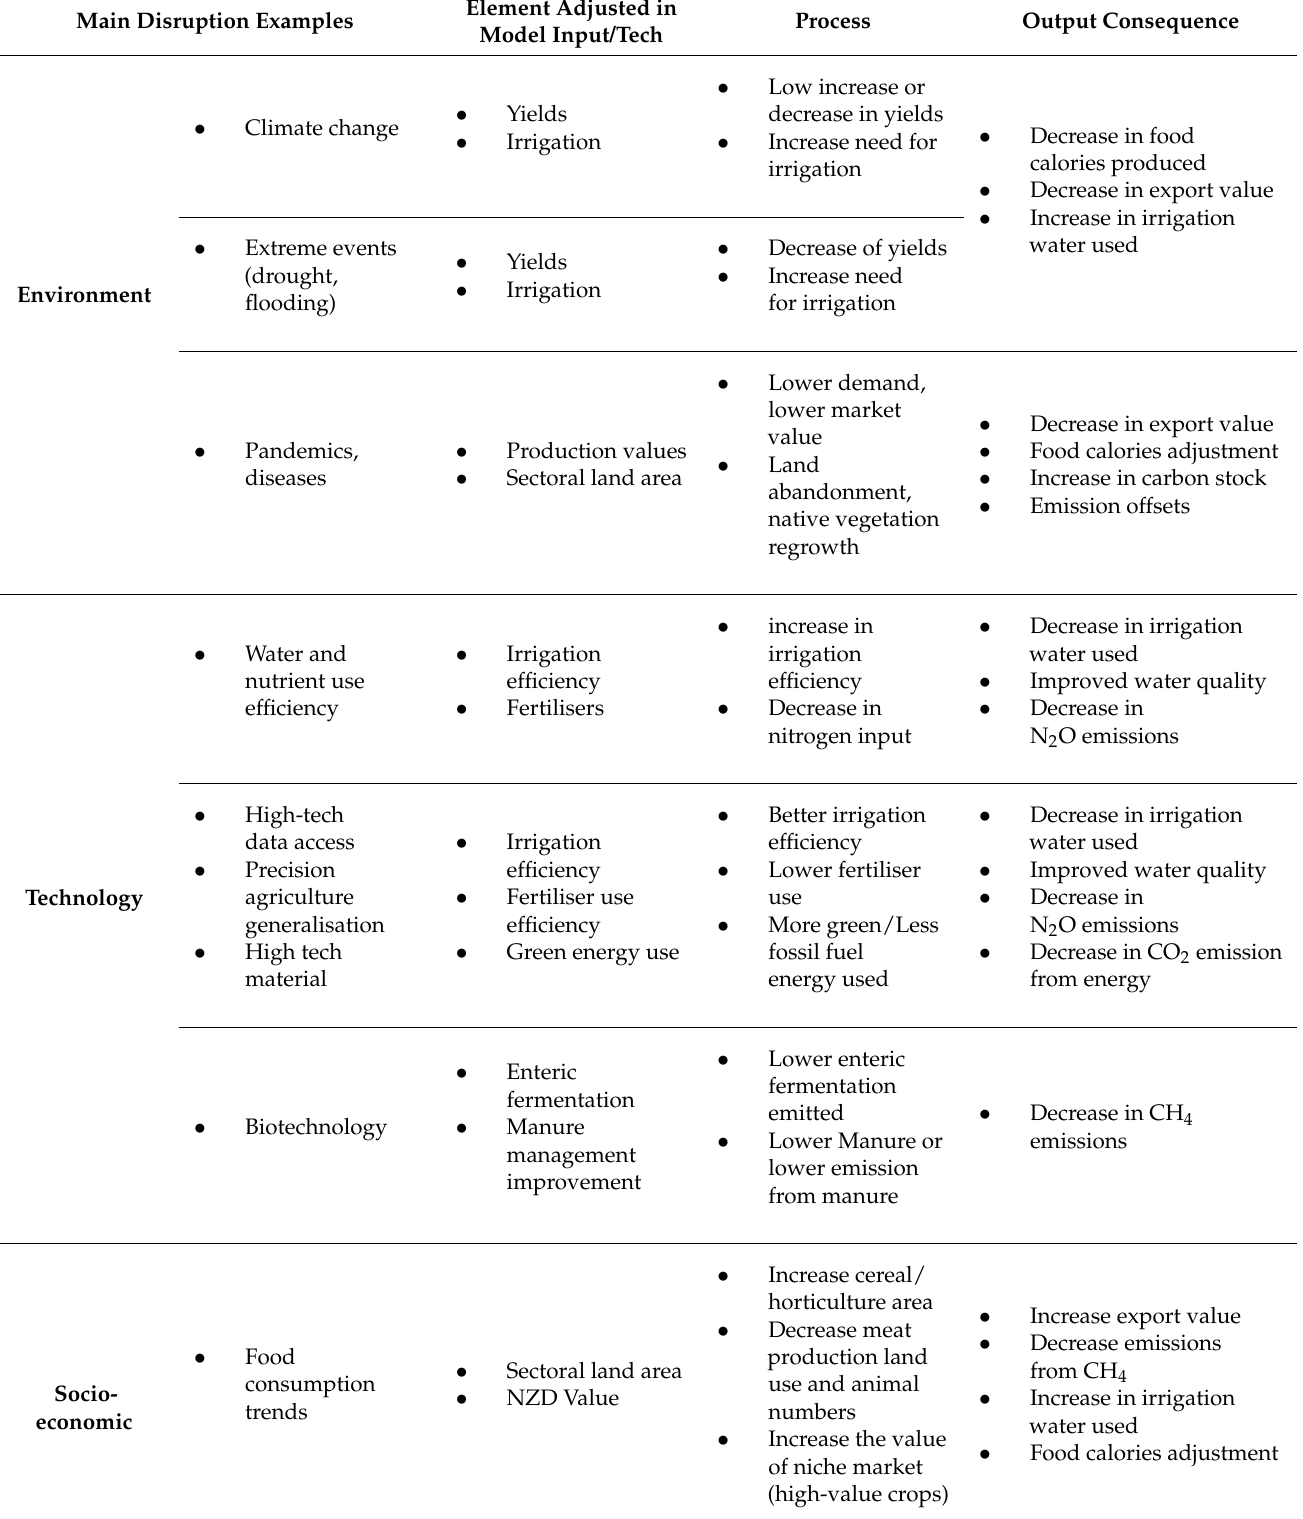
Table 1. Model processes and responses according to disruption